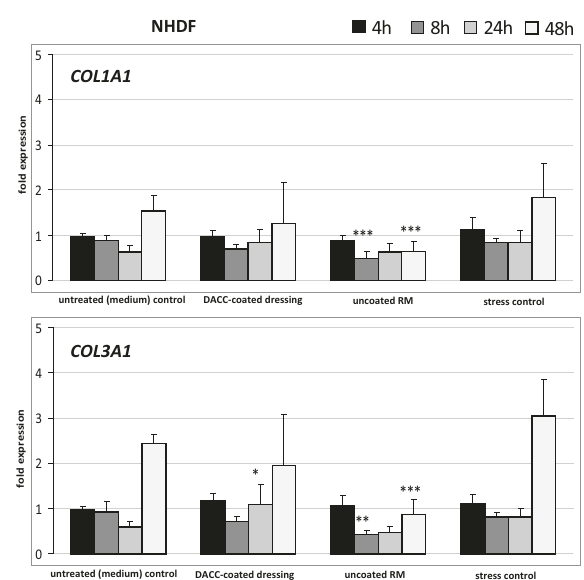
Fig. 8 Collagen gene expression under treatment with DACC and uncoated RM during NHDF scratch wound healing compared to the untreated (medium) control and the stress control. Quantitative ana- lyses of gene expression for collagen genes COL1A1 and COL3A1 were performed at 4, 8, 24, and 48 hours (h). Relative gene expression was normalized to the housekeeping gene ACTB . Data are presented as — fold gene expression compared to the untreated (medium) control at the start of the experiment. Asterisks indicate a signi fi cant deviation at the respective time point from the untreated control (* p < 0.05; ** p < 0.01; *** p <